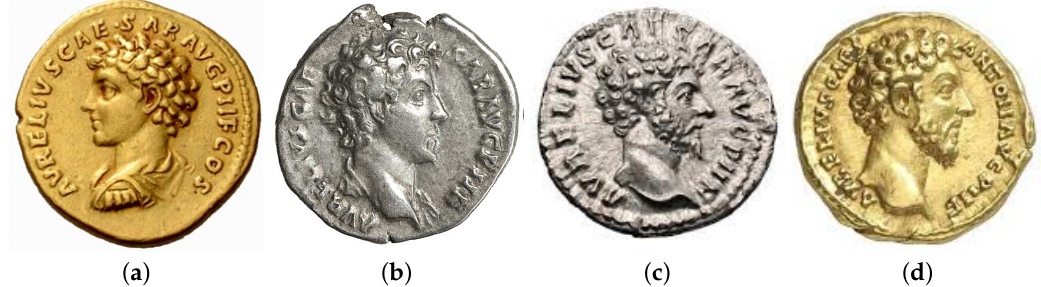
Figure 4. Examples of appearance variability in the depiction of the same individual (emperor Marcus Aurelius) on different coin issues ( a – d ). The challenge of ‘face recognition’ in this context, involving artistic stylization and abstraction, can be seen to eclipse that of conventional face recognition— a problem which has been attracting an enormous amount of research attention for some five decades, and yet still remains unsolved for nearly all practical